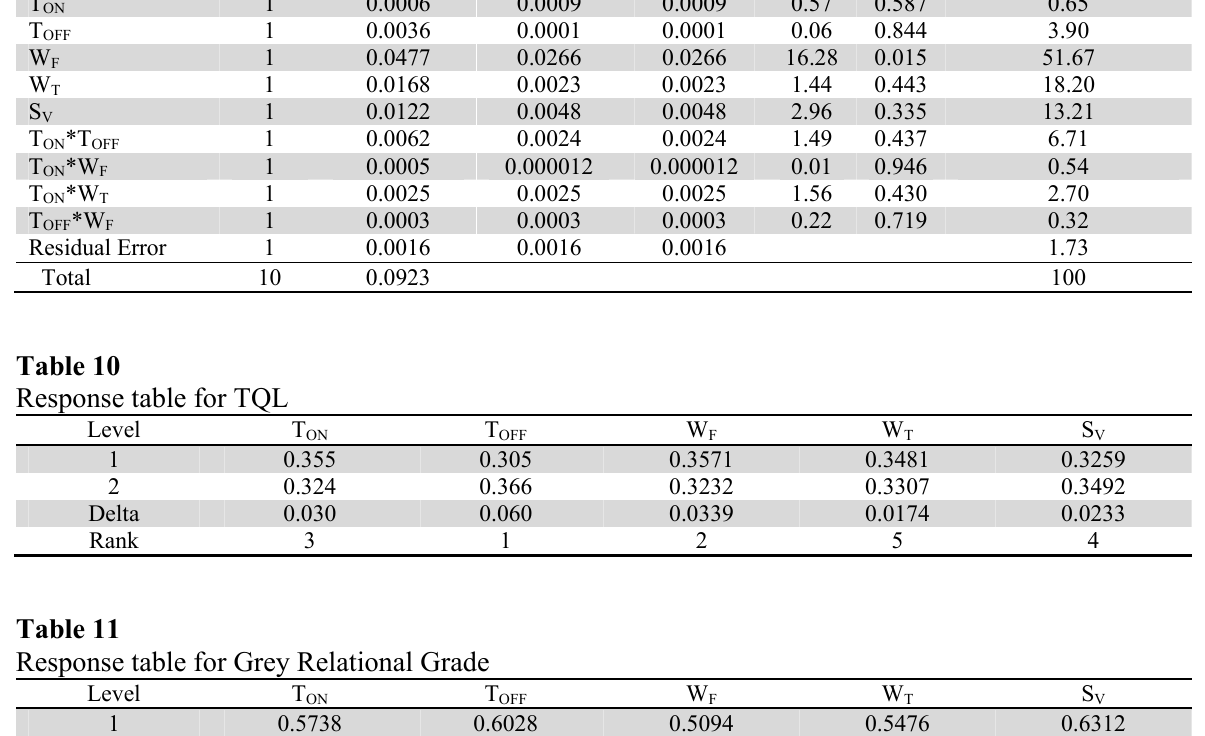
ANOVA for Grey Relational Grade Source